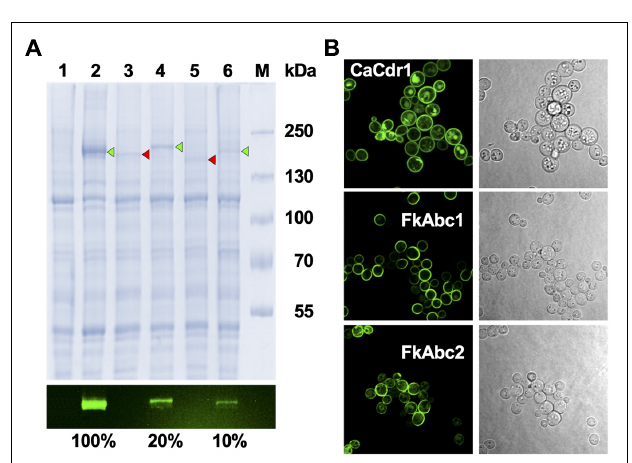
FIGURE 5 | Expression and localisation of Fk Abc1 and Fk Abc2 in S. cerevisiae AD (cid:49)(cid:49) . (A) SDS-PAGE of plasma membranes (10 µ g protein) isolated from S. cerevisiae AD (cid:49)(cid:49) cells (lane 1; negative control) or from AD (cid:49)(cid:49) cells overexpressing C. albicans Cdr1-GFP (lane 2; positive control), F. keratoplasticum 2781 Abc1 (lane 3), Abc1-XLmGFPHis (lane 4), Abc2 (lane 5), and Abc2-XLmGFPHis (lane 6); lane M is the molecular weight markers [molecular weights (kDa) are indicated]. The image underneath shows the green fluorescence signals of the C-terminally GFP tagged proteins that were used to quantify the expression levels, expressed as % of Cdr1-GFP. The image above was obtained from the same SDS-PAGE gel after Coomassie Blue R-250 staining. Arrowheads point to GFP-tagged (green) or untagged (red) protein bands, respectively. (B) Confocal microscopy of AD (cid:49)(cid:49) cells overexpressing Ca Cdr1-GFP, Fk Abc1-XLmGFPHis, and Fk Abc2-XLmGFPHis. GFP signals were detected with a LSM800 confocal microscope (Zeiss, Germany) at 630 × magnification. For optimum visualisation the argon laser intensities were adjusted to 4% for Ca Cdr1-GFP and 7% for Fk Abc1-XLmGFPHis and Fk Abc2-XLmGFPHis, respectively. Images on the right are light microscopy images of the same